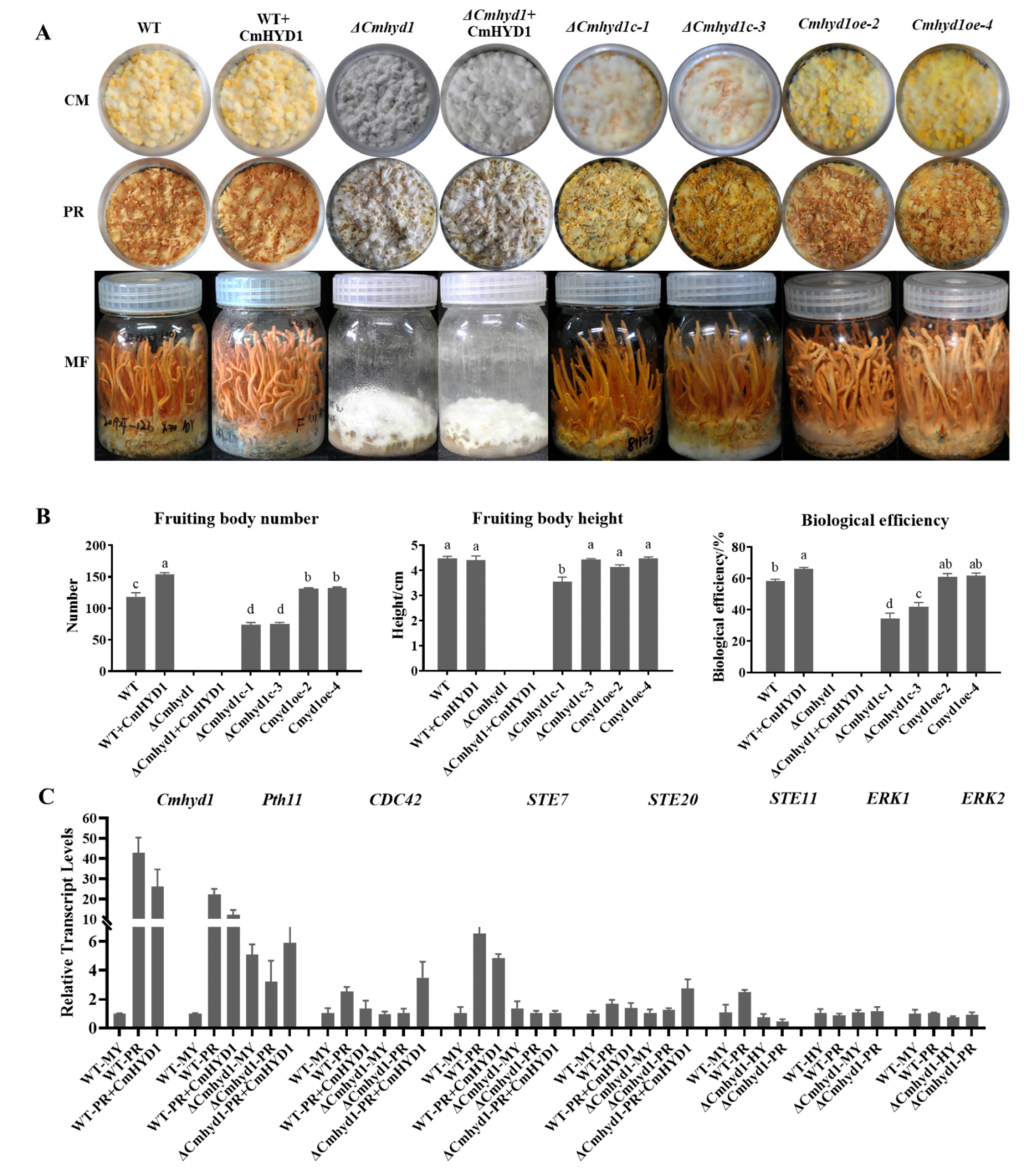
Figure 6. Cmhyd1 regulates fruiting body development in Cordyceps militaris . ( A ) Fruiting body development of WT and mutants. CM: the colored mycelia after light irradiation for 4 d; PR: primordium formation (stroma < 1 cm); MF: mature fruiting body. “WT + CmHYD1” and “ ∆ Cmhyd1 + CmHYD1” indicate that exogenous CmHYD1 was added to the WT and ∆ Cmhyd1 strains cultured on wheat media. ( B ) Effects of Cmhyd1 on mushroom yield. Fruiting bodies were harvested on 45th day after inoculation. The different letters over the histogram indicate significant differences at p < 0.05. ( C ) The relative transcript levels of Cmhyd1 and fruiting body development-related genes at primordial stage. All the results were based on the standard levels of the mycelial stage (MY) of WT strain. Error bars indicate the standard deviation (SD) of three biological replicates with two technical